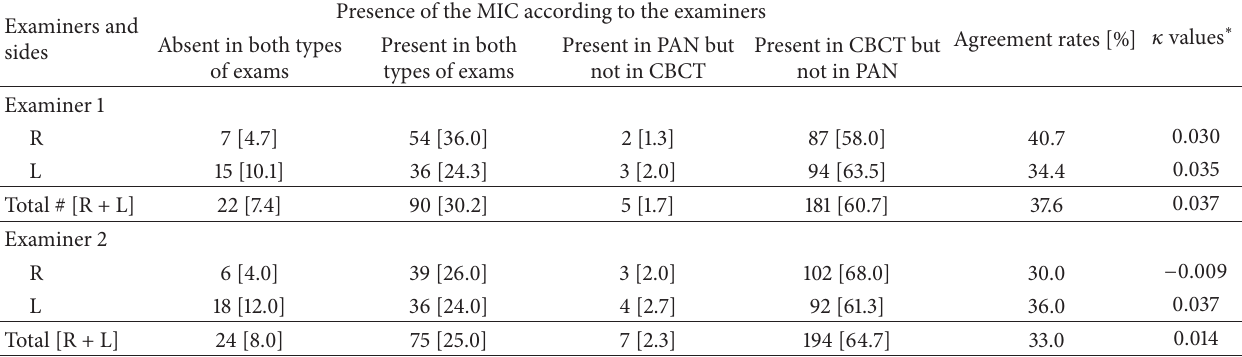
Table 2: Mandible incisive canal [MIC] as identified by examiners in images of panoramic radiograph [PAN] and cone-beam computed tomography